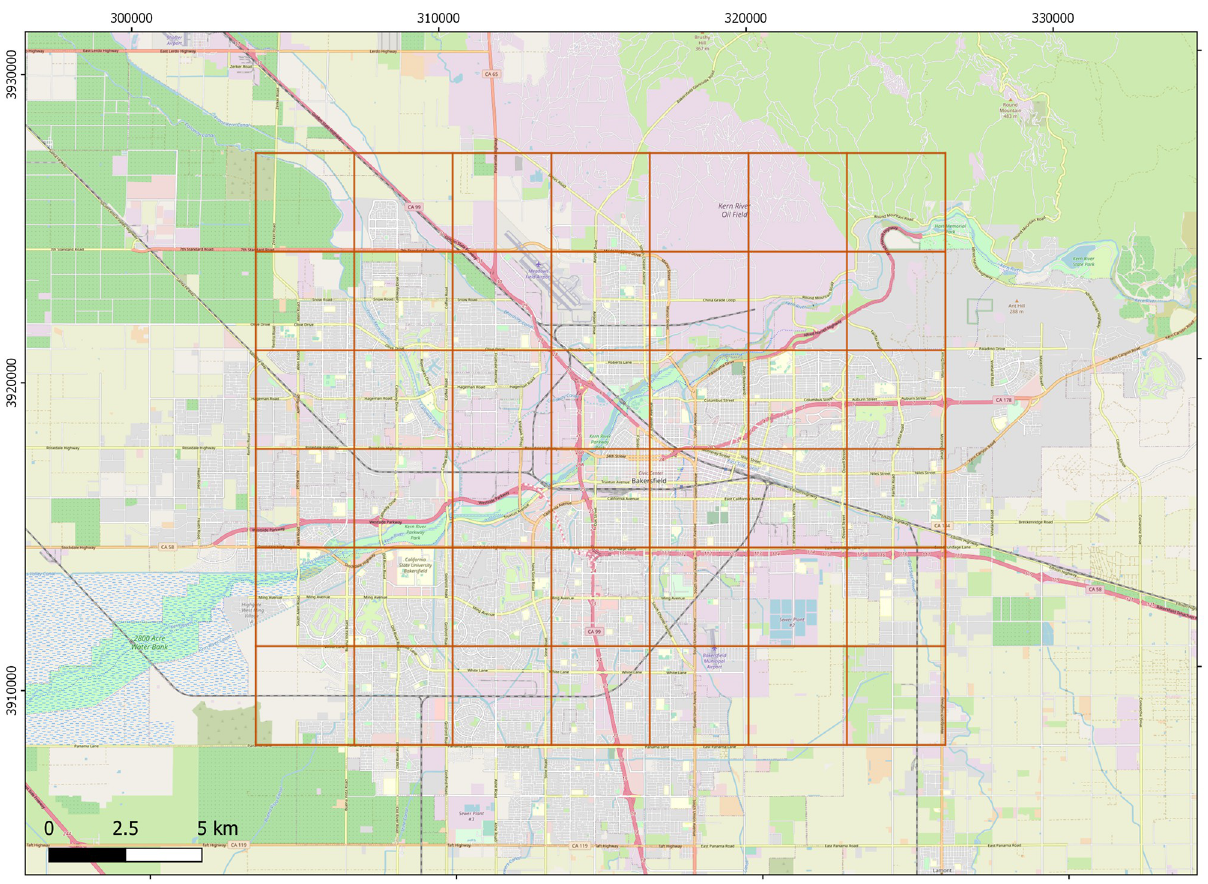
Fig 1. Image of Bakersfield core area occupied by San Joaquin kit foxes, divided in an array of 49 “quads”, each with its own local carrying capacity. Each grid is 2 mi 2 . Base map and data from OpenStreetMap and OpenStreetMap Foundation.